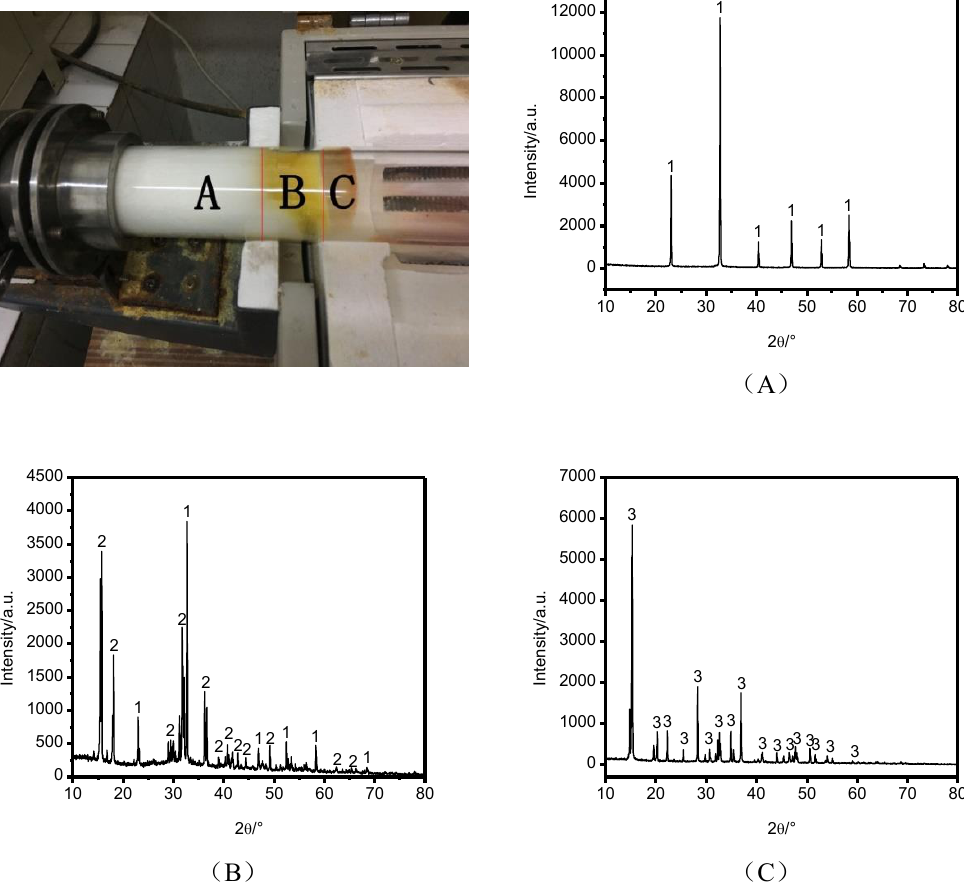
Figure 9. XRD patterns of condensation products of volatile gases calcined at 335 C: 1- Ammonium Chloride (NH 4 Cl), 2- Ammonium Aqua Iron Chloride ((NH 4 ) 2 FeCl 5 H 2 O), 3- Iron Chloride Hydrate (FeCl 3 ·6H 2 O).